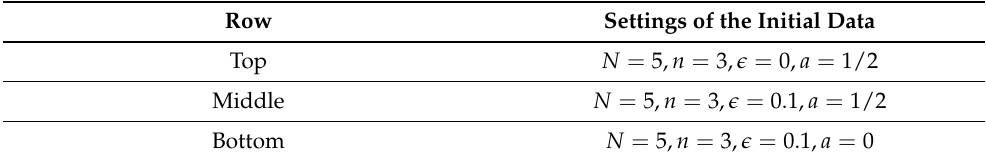
Table 1. This table states the correspondence between patterns shown in Figure 1 and concrete versions of the initial data (5).